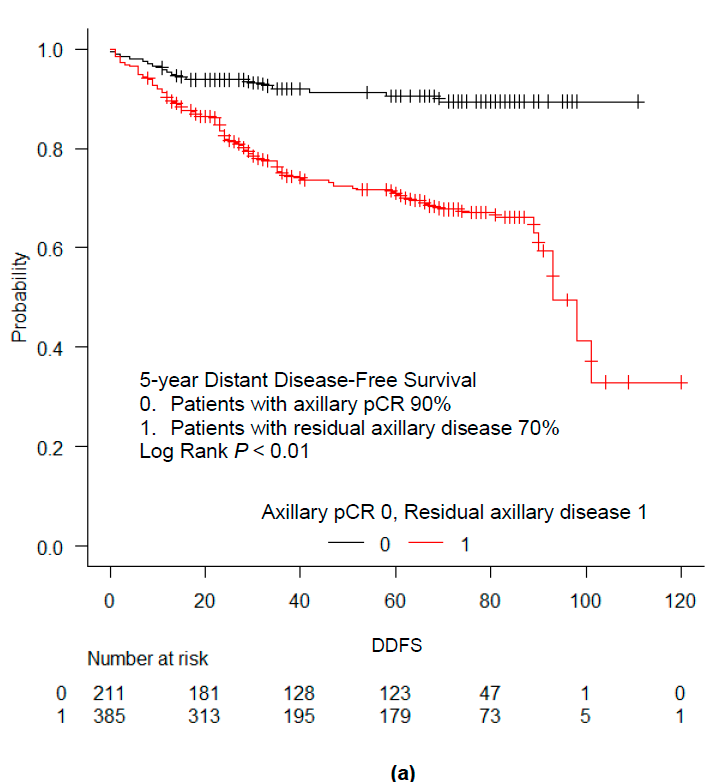
Table 1. Clinicopathological characteristics of patients after neoadjuvant chemotherapy (NAC).